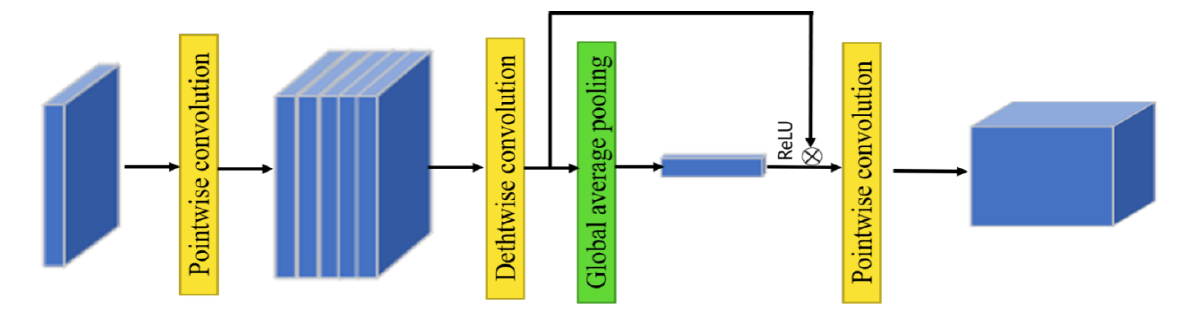
Figure 11. Structure of an SE block.